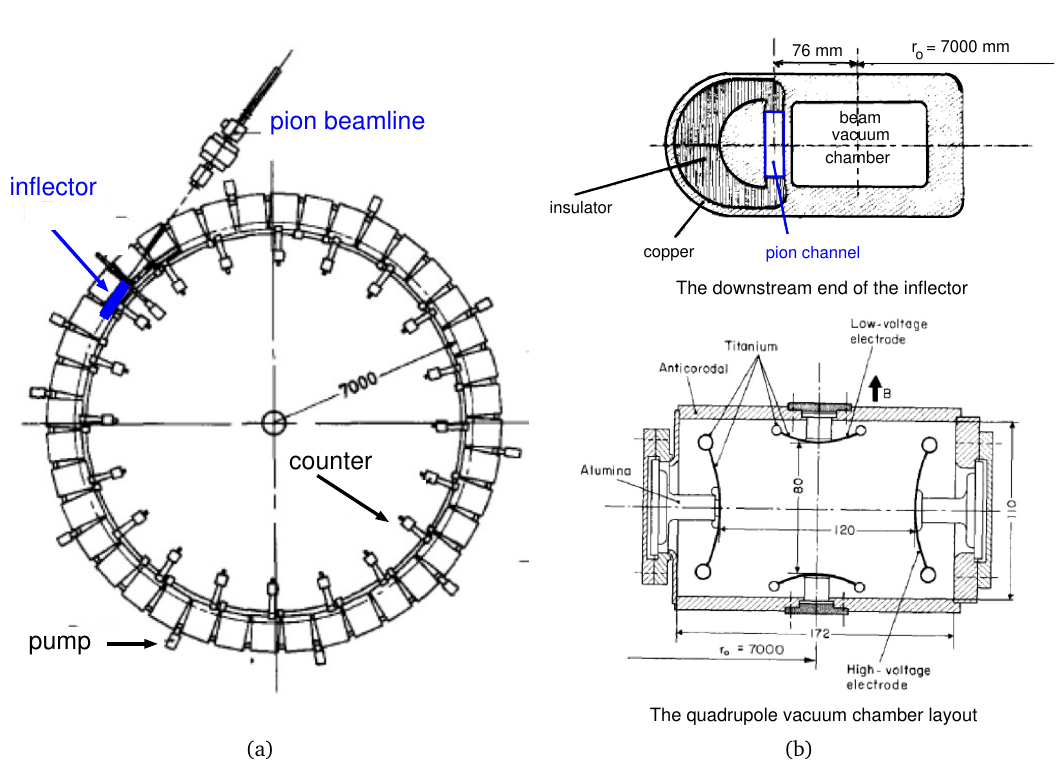
Figure 6: (a)A plan view of the 7,000 mm diameter CERN-3 storage ring, showing the 40-magnet ring. (From Ref. [ 43 ] re-labeled for clarity.) (b) Upper figure: The downstream end of the pulsed inflector magnet of the CERN-3 experiment. (From Ref. [ 43 ] re-labeled for clarity.) Lower figure: The electric quadrupole arrangement inside of the rectangular vacuum chamber profile. (From Ref. [ 43 ]